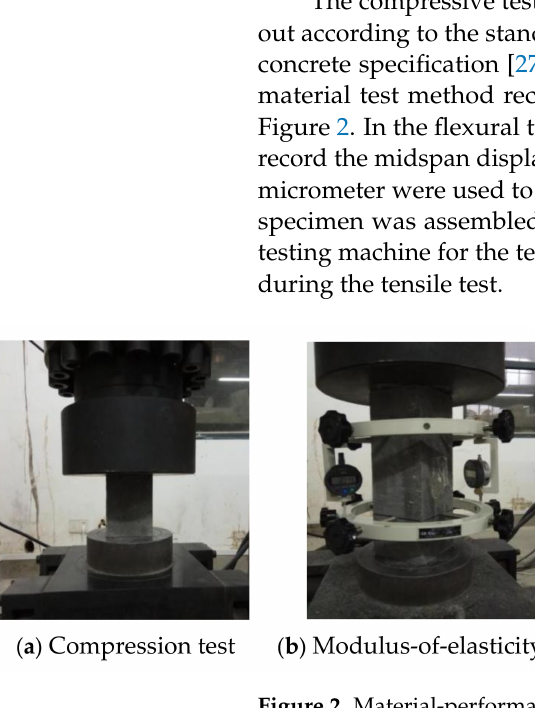
Figure 2. Material-performance